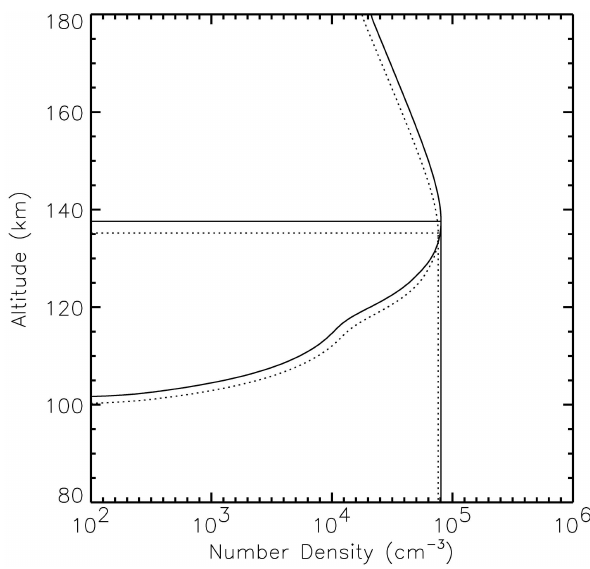
Figure 3 Fig. 3. The Martian ionosphere affected by the solar wind. When a